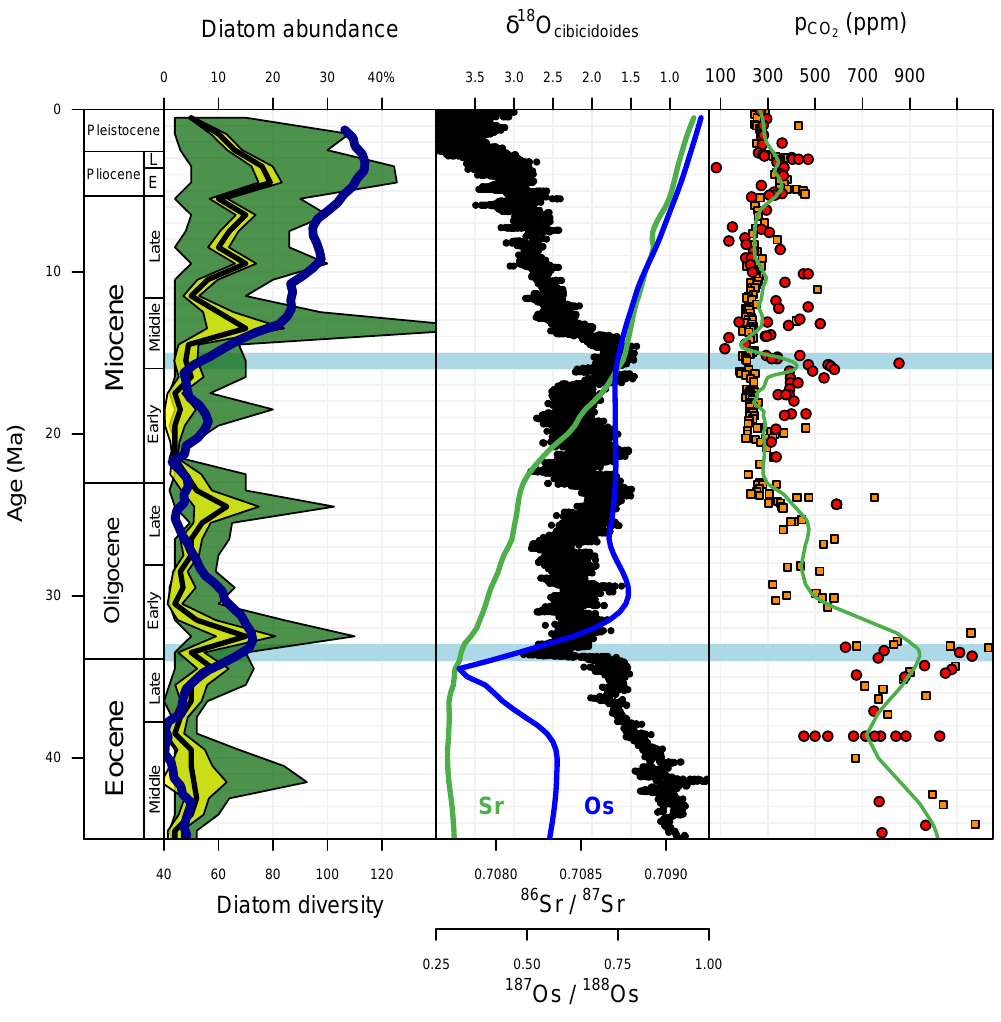
Figure 5. Comparison with climate and oceanography proxies. First panel – diatoms. The bold blue line is the diatom diversity from Lazarus et al. (2014). Diatom abundance as in Fig. 3. Second panel – benthic δ 18 O (black) from Zachos et al. (2008); LOESS regression curve (Cleveland et al., 1992) of strontium (green) and osmium (blue) isotope data based on compilation by Ravizza and Zachos (2003). Third panel – Cenozoic p CO reconstruction. Orange squares (phytoplankton-based proxy) and red dots (other proxies) from Beerling and Royer 2 (2011). The green line is a LOESS regression curve of these